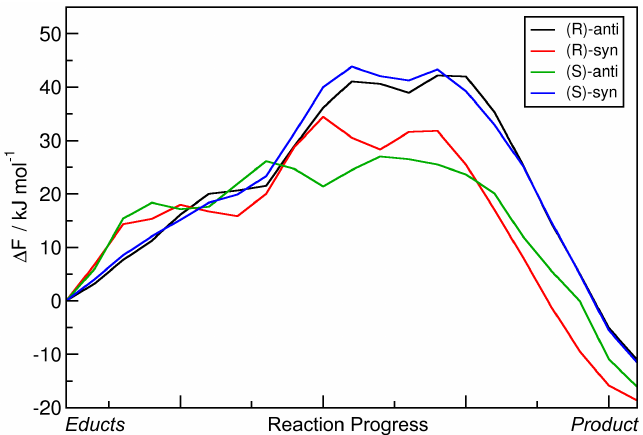
Figure 9. One-dimensional free energy profiles of aldol reactions (R=Et) in dimethylformamide (DMF) obtained from HyAIMD metadynamics; corresponds to red curves in Figure 8. Free energies are given relative to